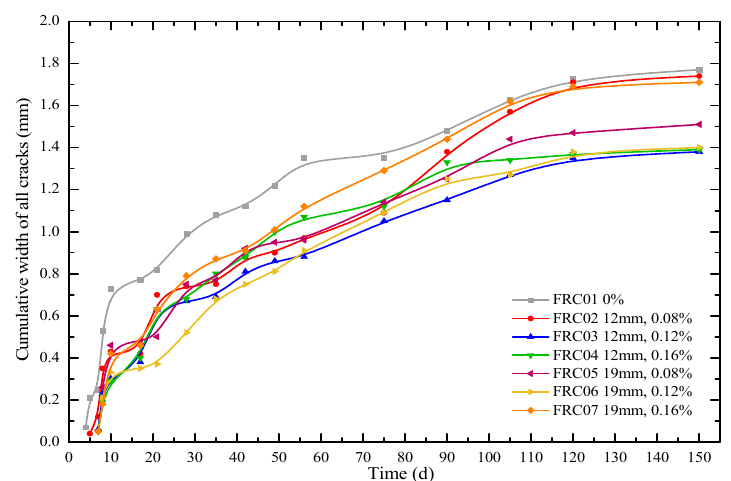
Figure 16. Cumulative width cracks in the concrete specimens during 150 days.